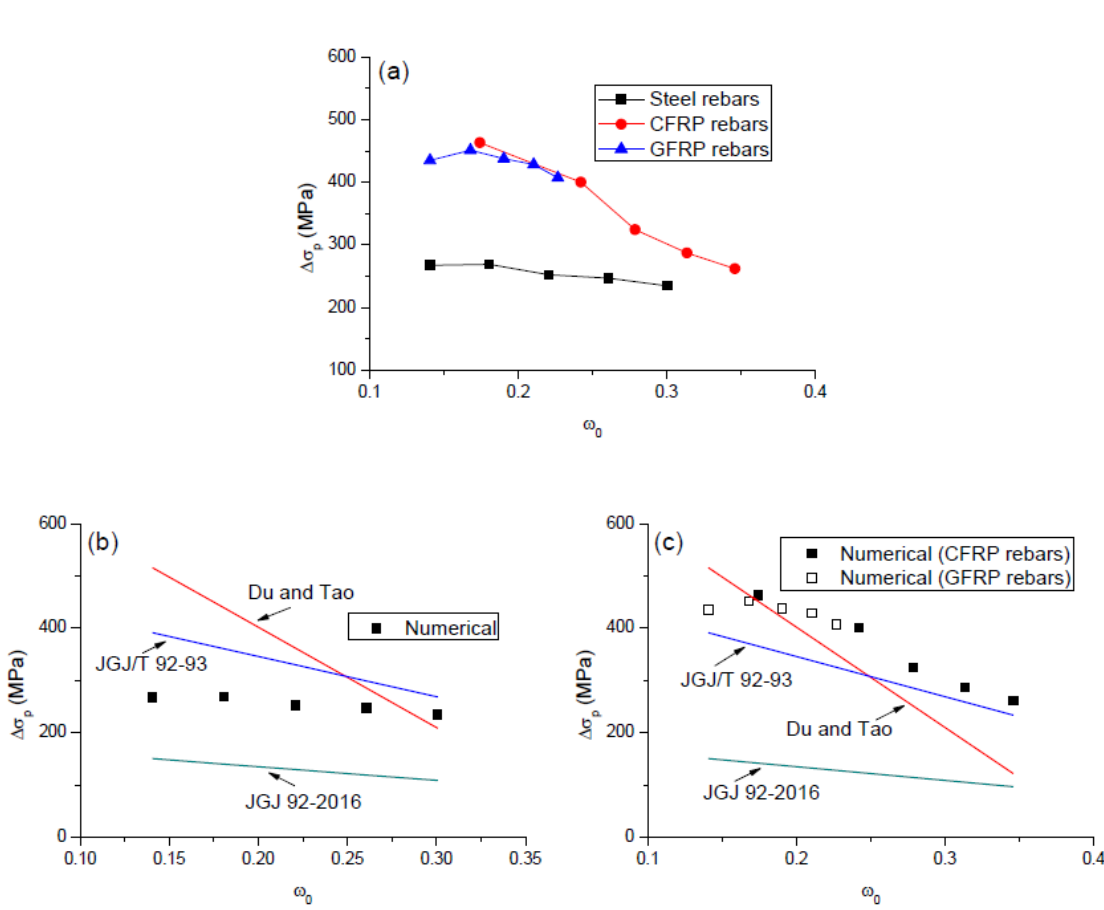
Figure 10. Relationship between tendon stress increment and combined reinforcing index. ( a ) numerical results; ( b ) comparison between simplified models and numerical data for the beams with steel rebars; ( c ) comparison between simplified models and numerical data for the beams with FRP rebars.